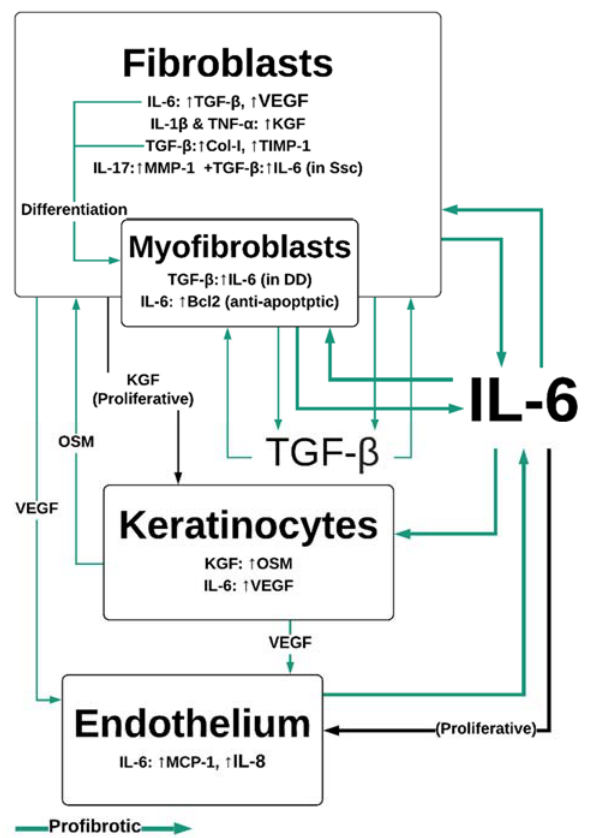
Figure 3. IL ‐ 6 and TGF ‐β‐ mediated interactions between dermal cells. IL ‐ 6 is central to profibrotic interactions between fibroblasts, myofibroblasts, keratinocytes and endothelial cells. IL ‐ 6 drives proliferation in endothelial cells in conjunction with VEGF, leading to neovascularization, which sustains pathological fibroproliferative scarring. IL ‐ 1 β , TNF ‐α and IL ‐ 6 are produced by M1 macrophages in the wound site, while IL ‐ 17 is produced by Th17 and γδ T ‐ cells. Col ‐ I—collagen 1; DD—Dupuytren’s disease IL—interleukin; KGF—keratinocyte growth factor; MCP ‐ 1—monocyte chemoattractant protein; MMP—matrix metalloproteinases; OSM—oncostatin M; SSc—systemic sclerosis; TGF ‐β —tissue growth factor β ; TNF ‐α —tumor necrosis factor alpha; VEGF—vascular endothelial growth factor.